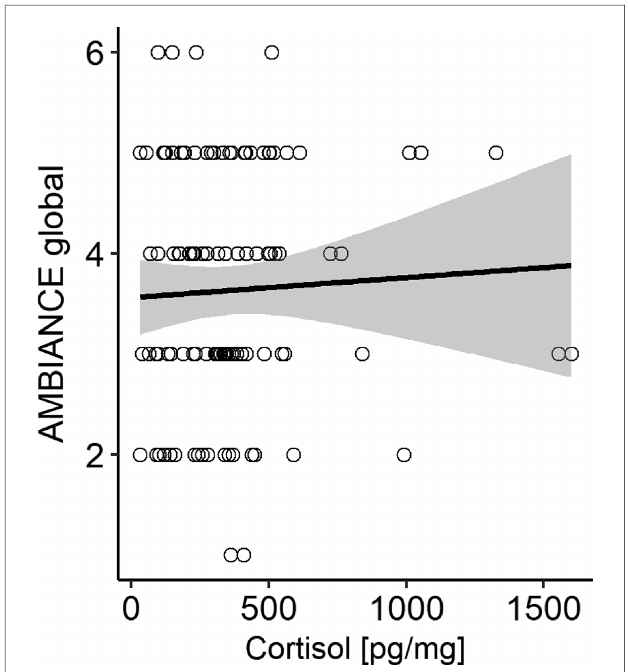
FIGURE 1 Scatterplot with HCC raw data for robust regression model including AMBIANCE global score as predictor. Grey areas depict the 95% con fi dence